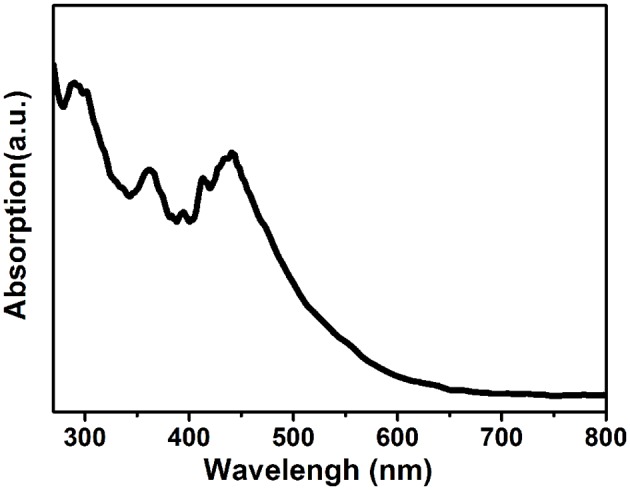
UV-visible absorption spectrum of (1-mPQBr)2MnBr4.